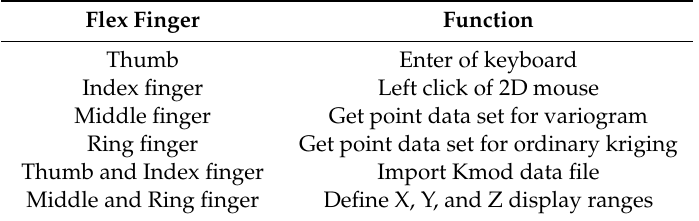
Table 2. Functions of bend-sensing data glove according to the user’s finger bending